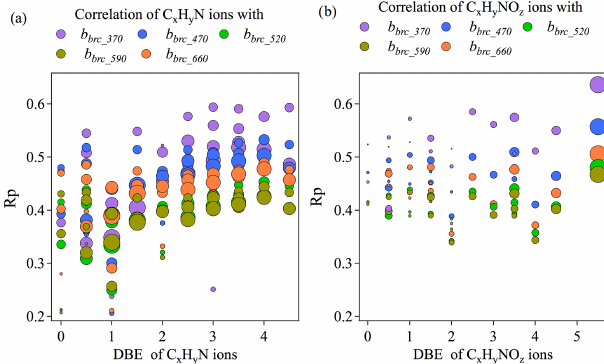
Figure 8. Correlation coefficients between BrC absorption coef- ficient across different wavelengths and N-containing organic ion fragments grouped by double bond equivalence (a, b) . Larger grey dots correspond to higher carbon